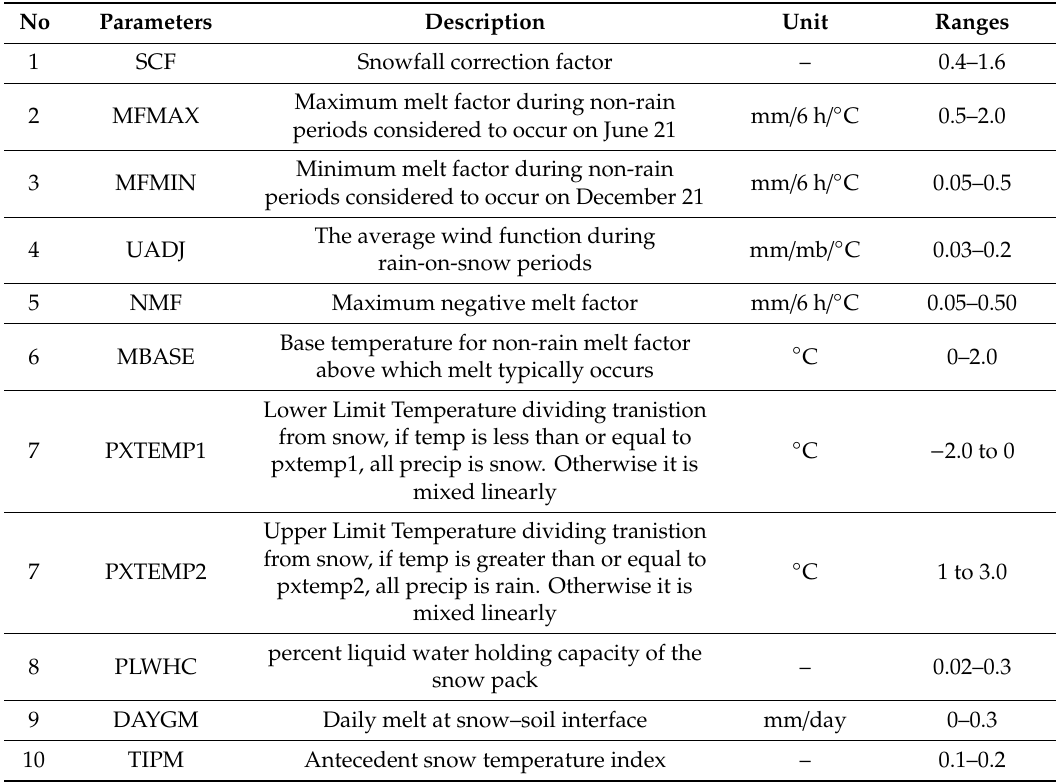
Table A1. SNOW17 model